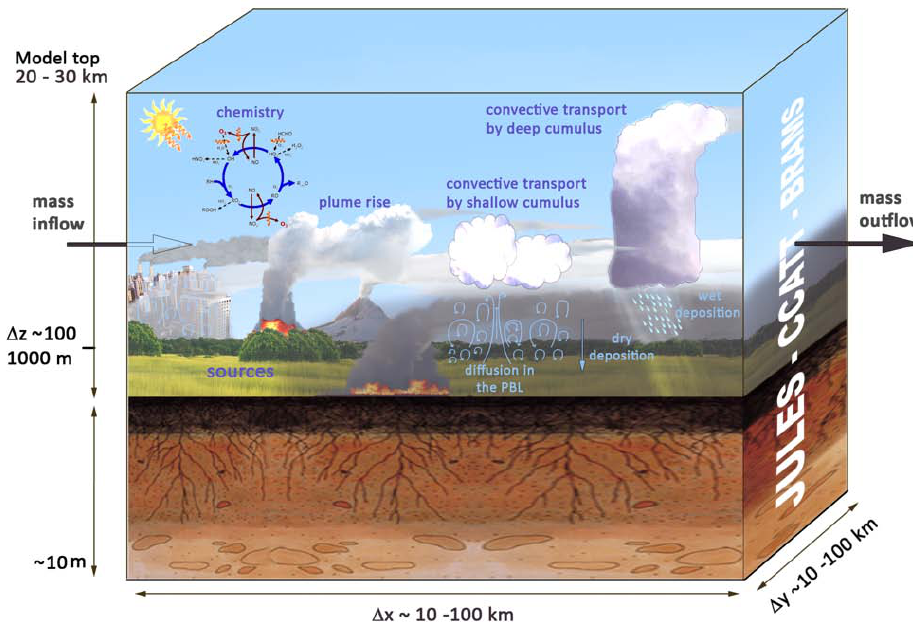
Fig. 2. Some of the sub-grid processes simulated by the JULES-CCATT-BRAMS model (adapted from http://meioambiente.cptec.inpe.br/ modelo